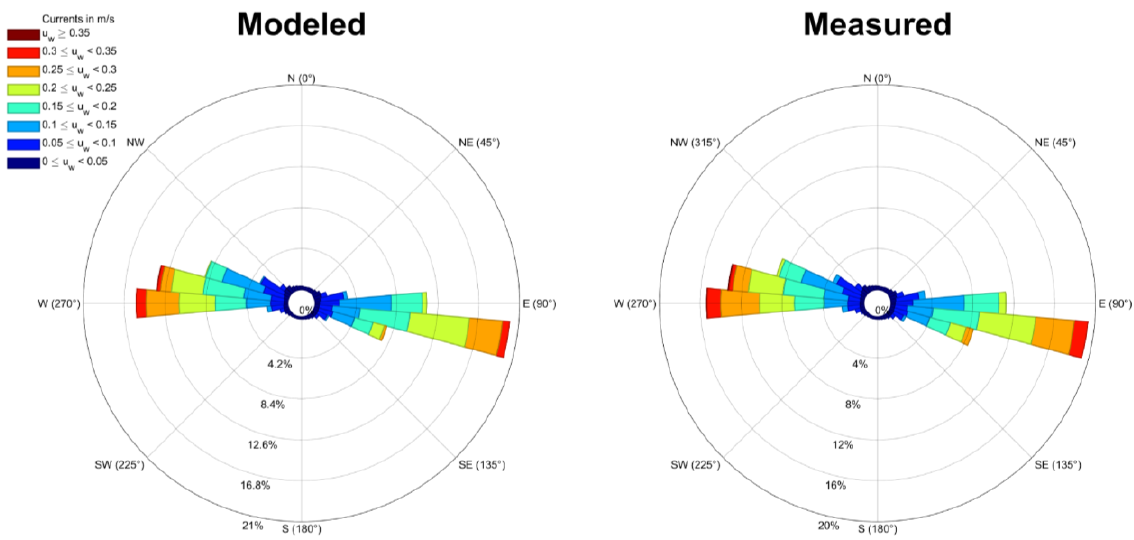
Figure 8. Comparison of the current roses for simulations and measurements of the calibration period.